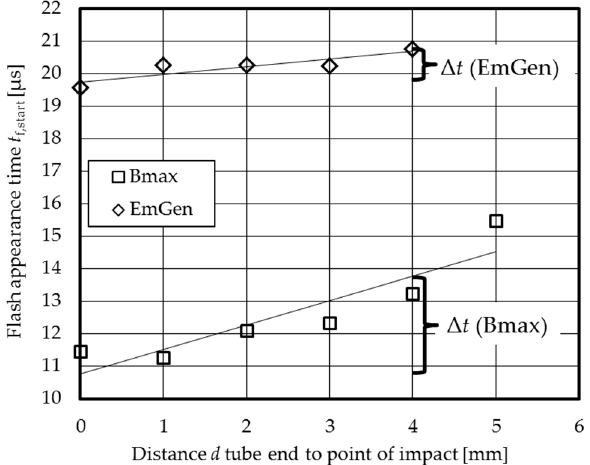
Figure 9. Mean values of flash appearance time t f,start, referring to the rising tool coil current at t = 0 µs as depicted in the schematic oscilloscope in Figure 1, at 90°, 180°, and 270° for varied values d for two MPW setups at the specific lower process boundary (Bmax: g = 1.5 mm, E = 4.5 kJ, I max = 380 kA, Ø tool coil = 41 mm, w c = 10 mm, l w = 6 mm, EmGen: g = 1.5 mm, E = 7 kJ, I max = 70 kA, Ø field shaper = 41 mm, w c = 10 mm, l w = 6 mm).